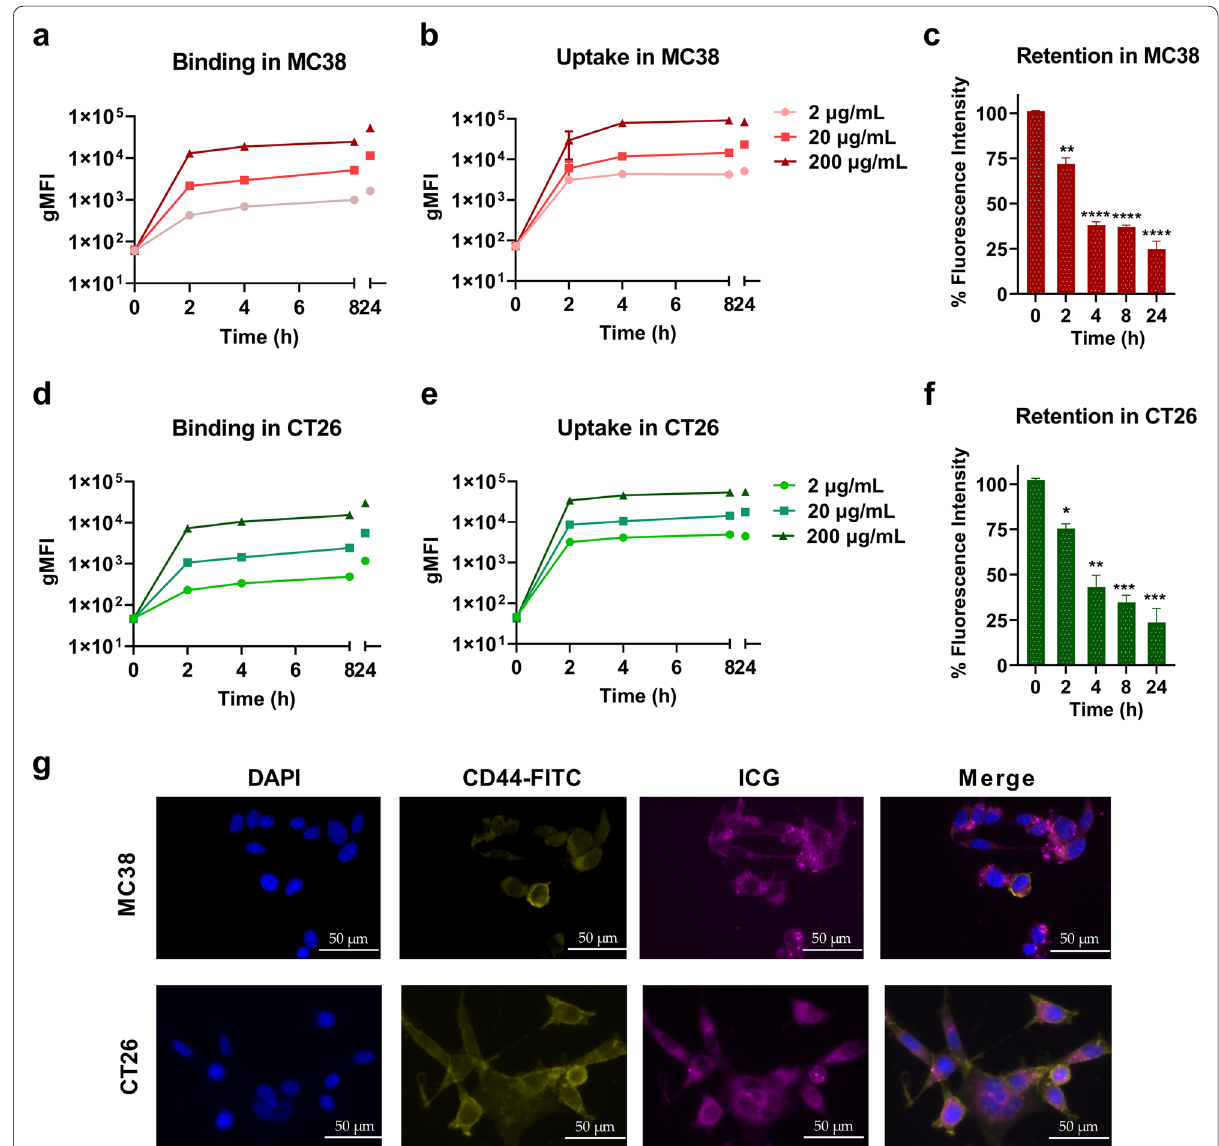
Fig. 1 Cellular properties of the photosensitizer ICG in vitro ( a ) Cellular binding and ( b ) uptake assays with 2 µg/mL, 20 µg/mL, and 200 µg/mL ICG in MC38 cells over time by incubating cells with ICG at 4 °C and 37 °C, respectively. Detection was performed by flow cytometry and represented as gMFI of ICG. ( c ) Retention of ICG (50 µg/mL) in MC38 cells after 4 h co-incubation, collected cells were washed and detected by flow cytometry. ( d ) Cellular binding and ( e ) uptake assays with 2 µg/mL, 20 µg/mL, and 200 µg/mL ICG in CT26 cells over time by incubating cells with ICG at 37 °C and 4 °C, respectively. ( f ) Retention of ICG (50 µg/mL) in CT26 cells after 4 h co-incubation, collected cells were washed and detected by flow cytometry. The fluorescence signal positive population is shown as a percentage of CRC cells. ( g ) Fluorescence microscopy images of ICG (50 µg/ mL)-treated MC38 and CT26 cells after 4 h of incubation. Scale bar 50 =